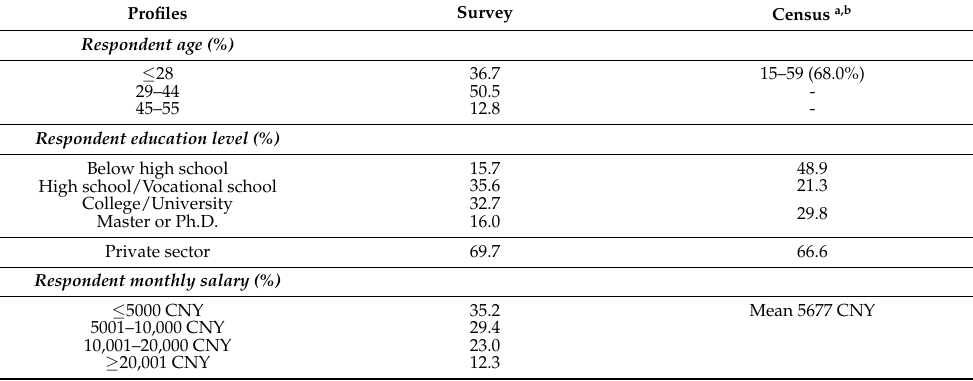
Table 1. Participant profile (N =